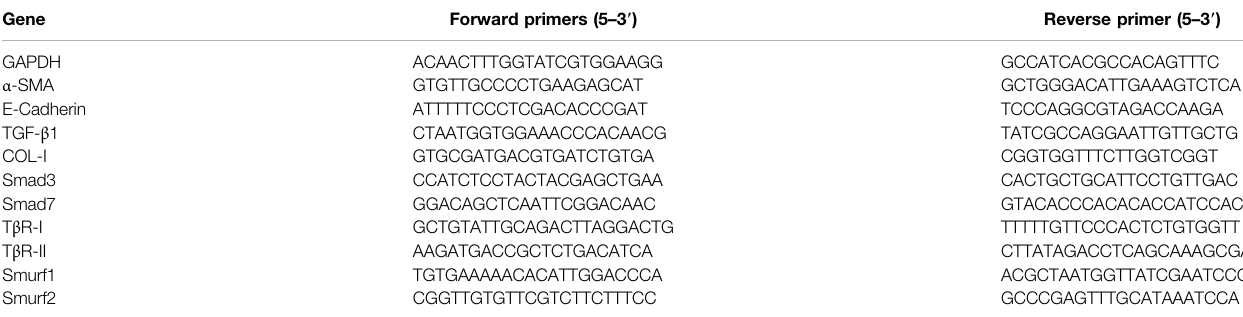
TABLE 2 | Primer sequences for quantitative real-time PCR ampli fi cation (Human).